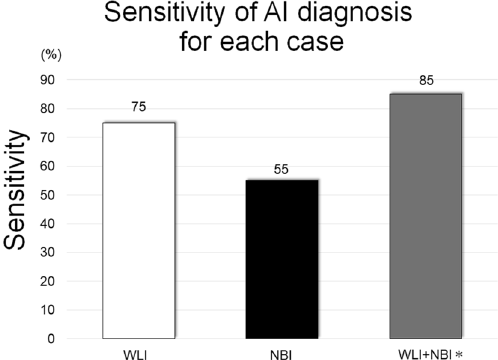
Figure 2. Sensitivity of the AI diagnosis for each case. The sensitivity of the AI diagnosis for each case was slightly higher in WLI than in NBI, but not significantly. * WLI + NBI: when a cancer was diagnosed with either WLI or NBI, we considered that the AI had detected the cancer. AI: artificial intelligence, WLI: white light imaging, NBI: narrow-band imaging.